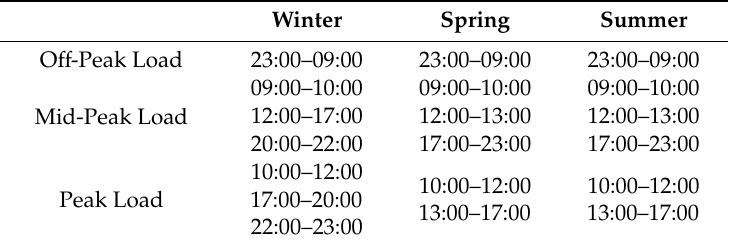
Table 1. Time Zones for o ff -Peak, mid-peak, peak load. Winter